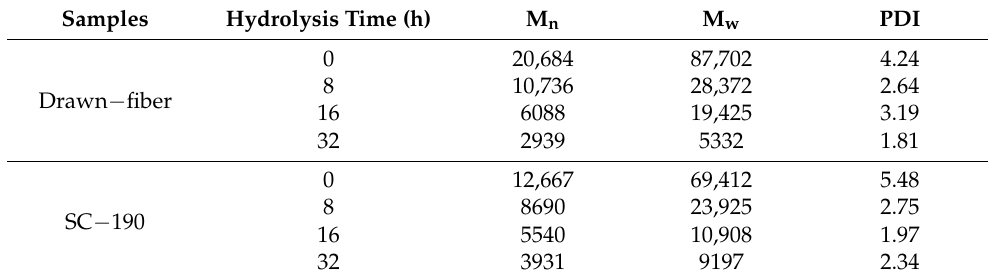
Table 6. Molecular weight and distribution of PLLA/PDLA fiber hydrolyzed for different times.